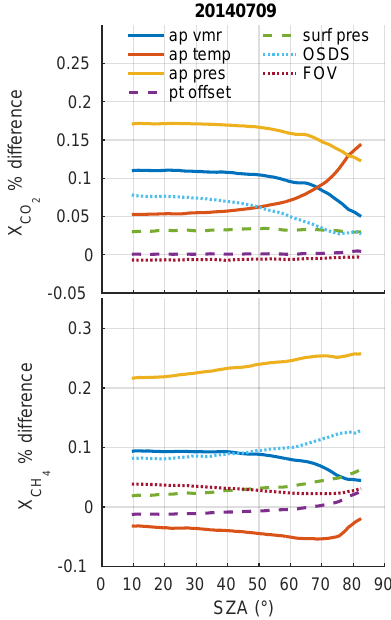
Figure 11. Uncertainty budget for EM27/SUN instruments using GGG2014. See Table 5 for magnitudes of